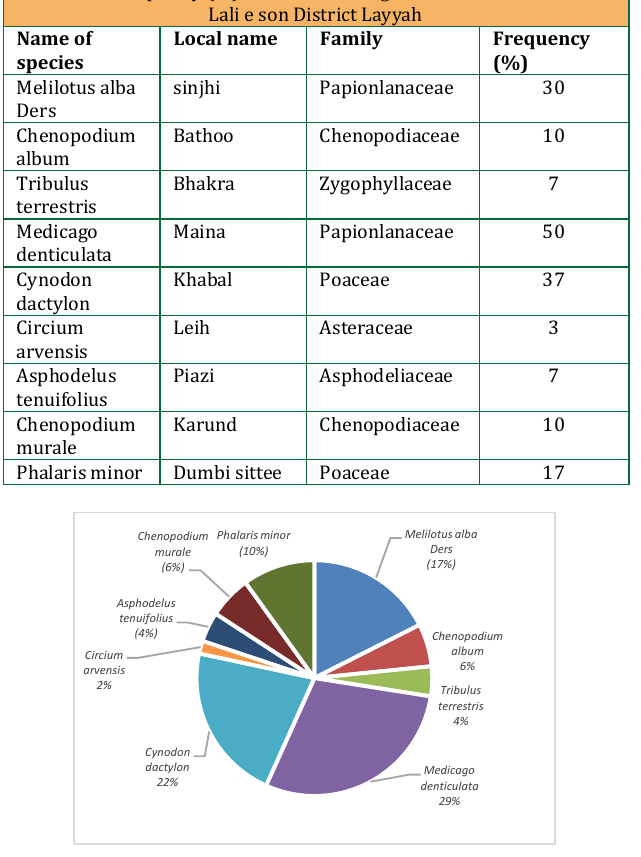
Figure 5: Frequency (%) of weed infesting of wheat at Karor site District Layyah. Table 6: Density (%) of weed infesting the wheat field at Karor Lali e Son District Layyah Name of species